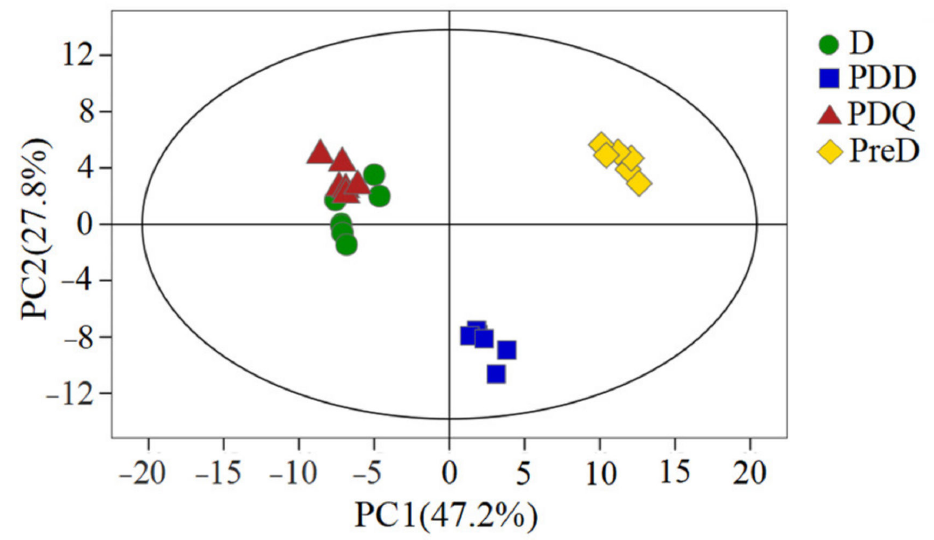
Figure 1. Principal component analysis (PCA) score plot of the metabolite profiles of S. mosellana larvae at pre-diapause (PreD), diapause (D), post-diapause quiescence (PDQ) and post-diapause development (PDD). Data points are displayed as sample projections onto the two primary axes. Oval represents the 95% confidence interval of the model using Hotelling T2 statistics. Variances explained by the first two components (PC1 and PC2) are shown in